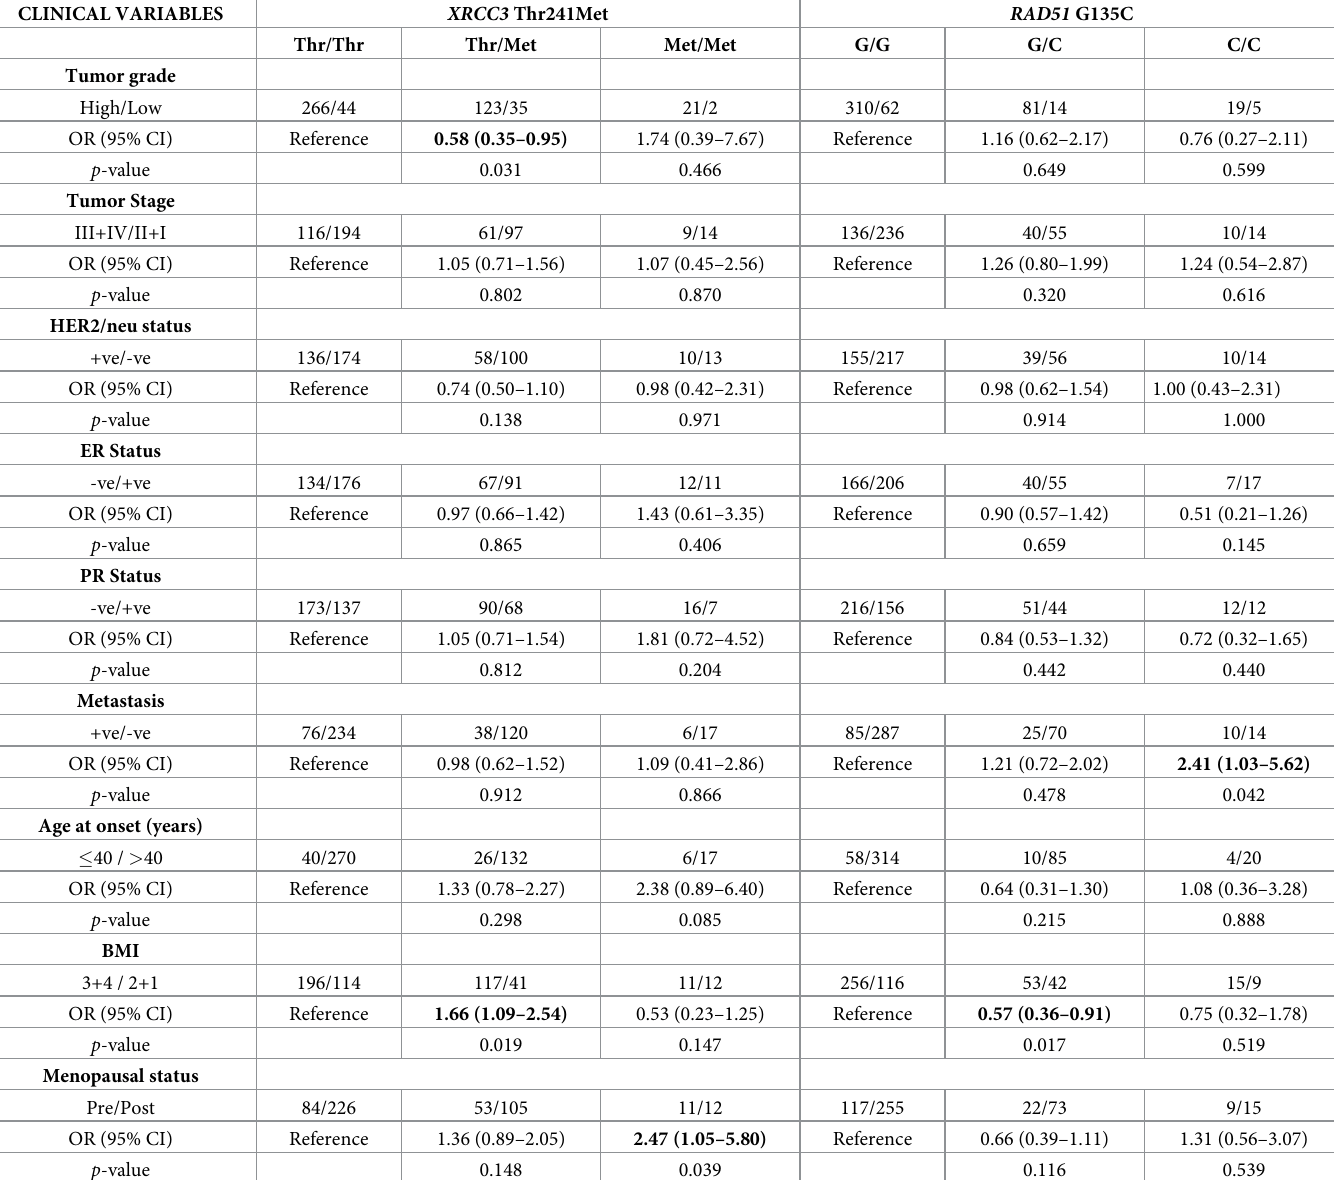
Table 4. Evaluation of XRCC3 and RAD51 variants with BC patients’ clinicopathological features. CLINICAL